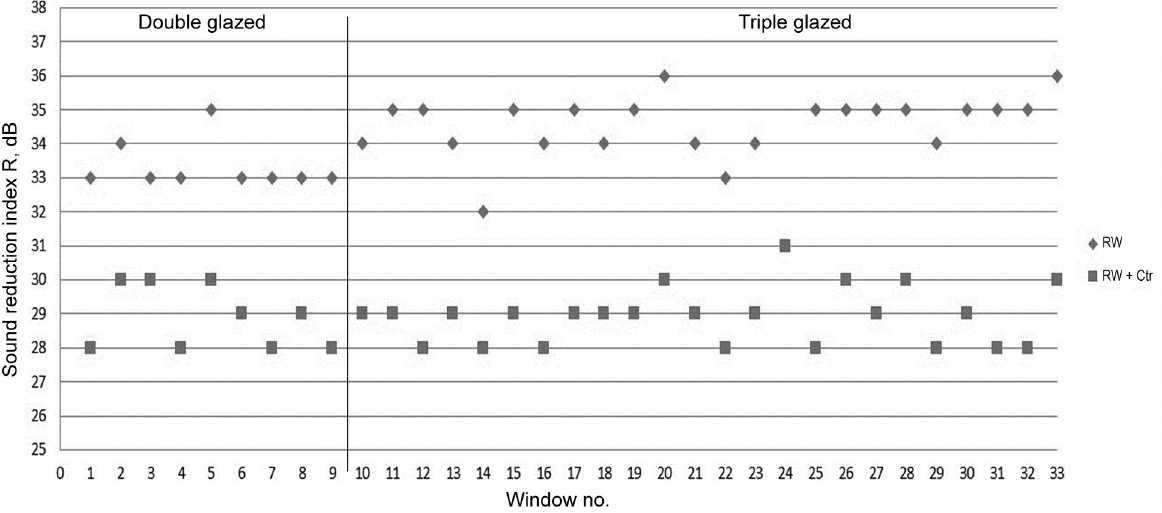
Figure 7. Sound insulation